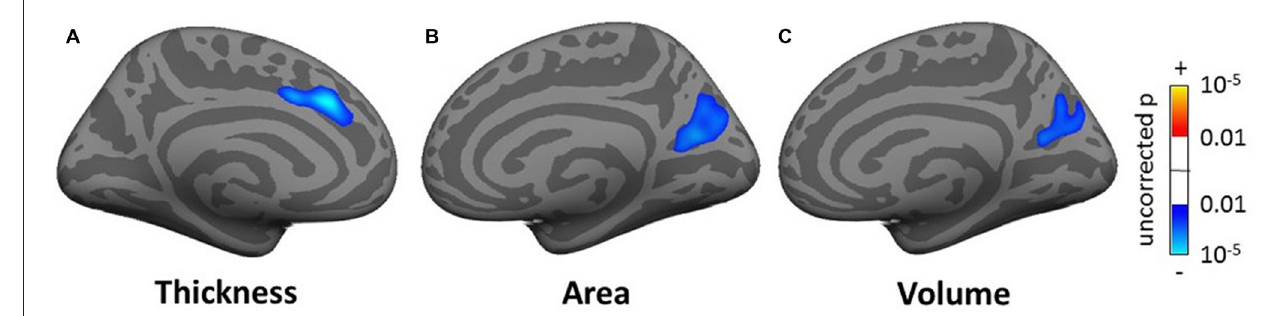
FIGURE 6 | Clusters showing a significant effect ( p < 0.05 family wise error (FWE)-corrected) of tinnitus in the superior frontal gyrus (SFG; A) and of tinnitus severity in the pre-cuneus (B,C) in the whole-brain surface-based morphometry (SBM) analysis. Blue areas correspond to a negative effect (decrease in thickness for the tinnitus group vs. the control group and decrease in area and volume for increasing tinnitus severity).